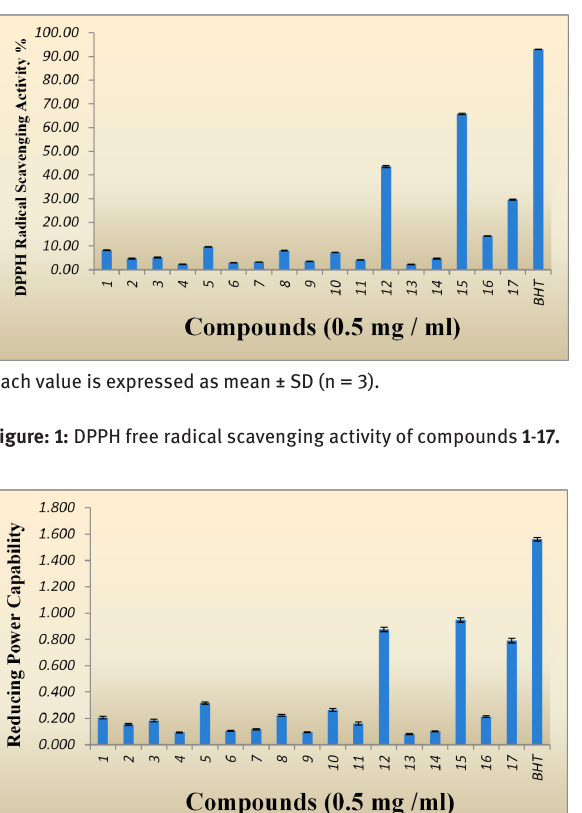
and 15 . Whereas compounds 1 - 11 appeared less active (Figure: 1). The reducing power capacities of pyrido- triazolopyrimidines 1 - 17 were compared with BHT (Figure: 2). Compounds 12 , 15 and 17 showed the highest